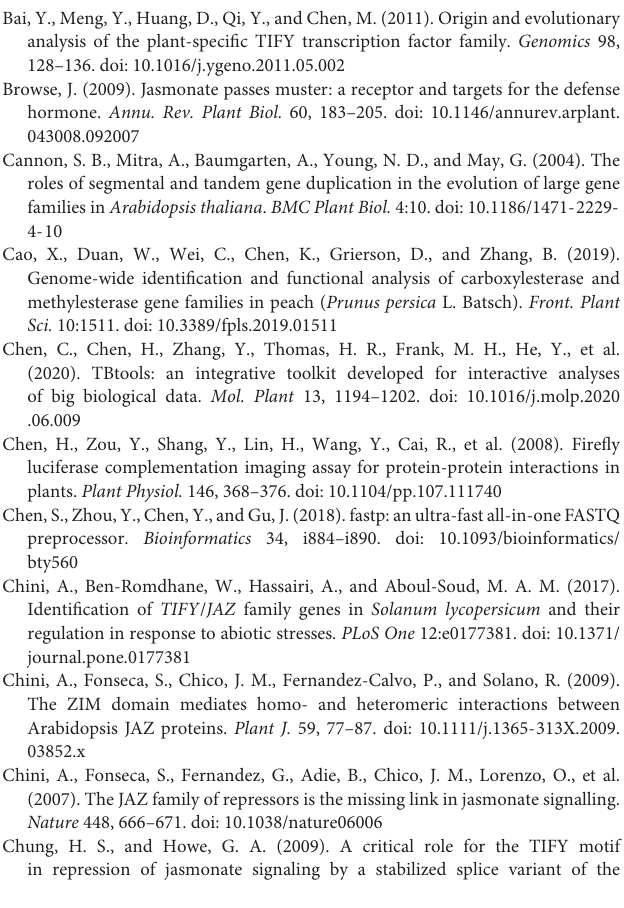
Supplementary Figure 3 | Alignment of the deduced MYC2 amino acid sequences. The following GenBank or genome sequencing project accession numbers were used: Arabidopsis thaliana AtMYC2 (At1g32640); Malus × domestica MdMYC2 (MDP0000136498); Fragaria vesca FvMYC2 (FvH4_7g17380.1); Solanum lycopersicum SlMYC2 (Solyc08g076930); and Pyrus pyrifolia PpyMYC2 (Ppy06g0316.1). Supplementary Table 1 | Primers used in this study.